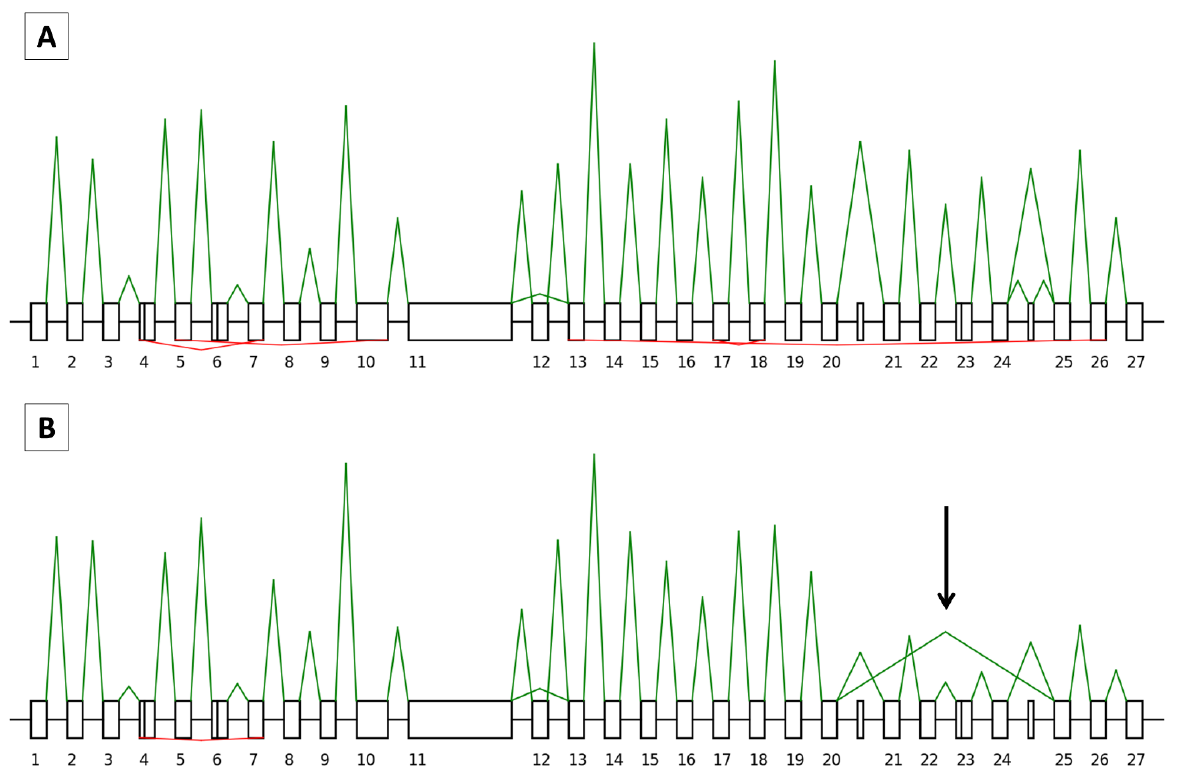
Figure 4. Representation of the BRCA2 splicing and backsplicing profiles for patient 20X0446, without a known pathogenic BRCA2 germline variant. Exons are drawn as boxes and are numbered, with the introns represented as lines. A solid line indicates alternative splice sites within the exons. Non- numbered boxes correspond to alternative exons that are not included in the canonical transcript. Peak heights are relative to the number of UMI counts. For each profile, splicing is indicated in green above the boxes and backsplicing in red below the boxes. ( A ) Normal breast tissue and BRCA2 canonical transcript with the delta 12 isoforms are shown. In red, below, the backsplicing from exons 7 to 4 (circRNA_7-4), 10 to 5 (circRNA_10-5), 18 to 17 (circRNA_18-17), and 26 to 13 (circRNA_26-13) is shown. ( B ) Tumor breast tissue, with the identification of an abnormal skipping from exons 20 to 25, indicated with an arrow, which was not present in the normal tissue.